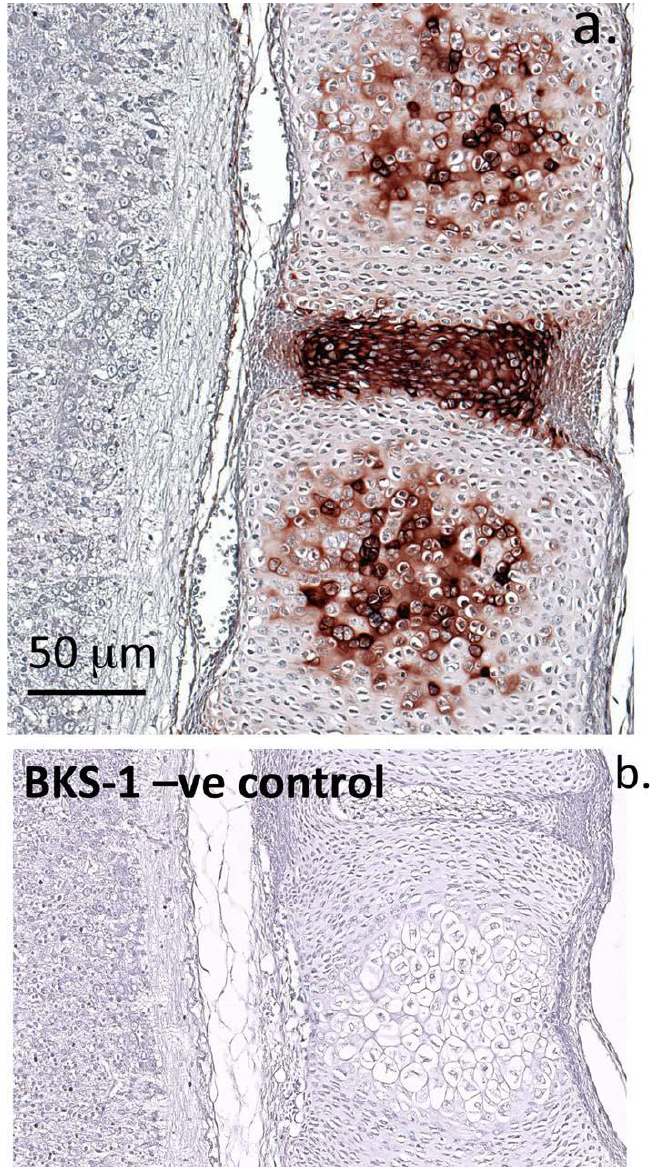
Figure 6. Immunolocalization of BKS-I(+) ( a ) in a late fetal rat spinal segment showing its localization in the pre-ossification centre within the vertebral body rudiment, and the cartilaginous inner annulus fibrosus of the disc. Note that the nucleus pulposus is outside the section plane of this parasagittal tissue slice taken through the disc. Chromogen used was novaRED. A negative control image is presented in ( b ). Labeling of BKS-1( + ) was highly prominent within the NP and AF of the IVD; however, it was not detected in the CEPs or adjacent GPs (Figure 6a). Lumican had a similar distribution to BKS-1( + ), occurring within the NP and AF. It too was absent from the CEPs; however, unlike BKS-1( + ) it